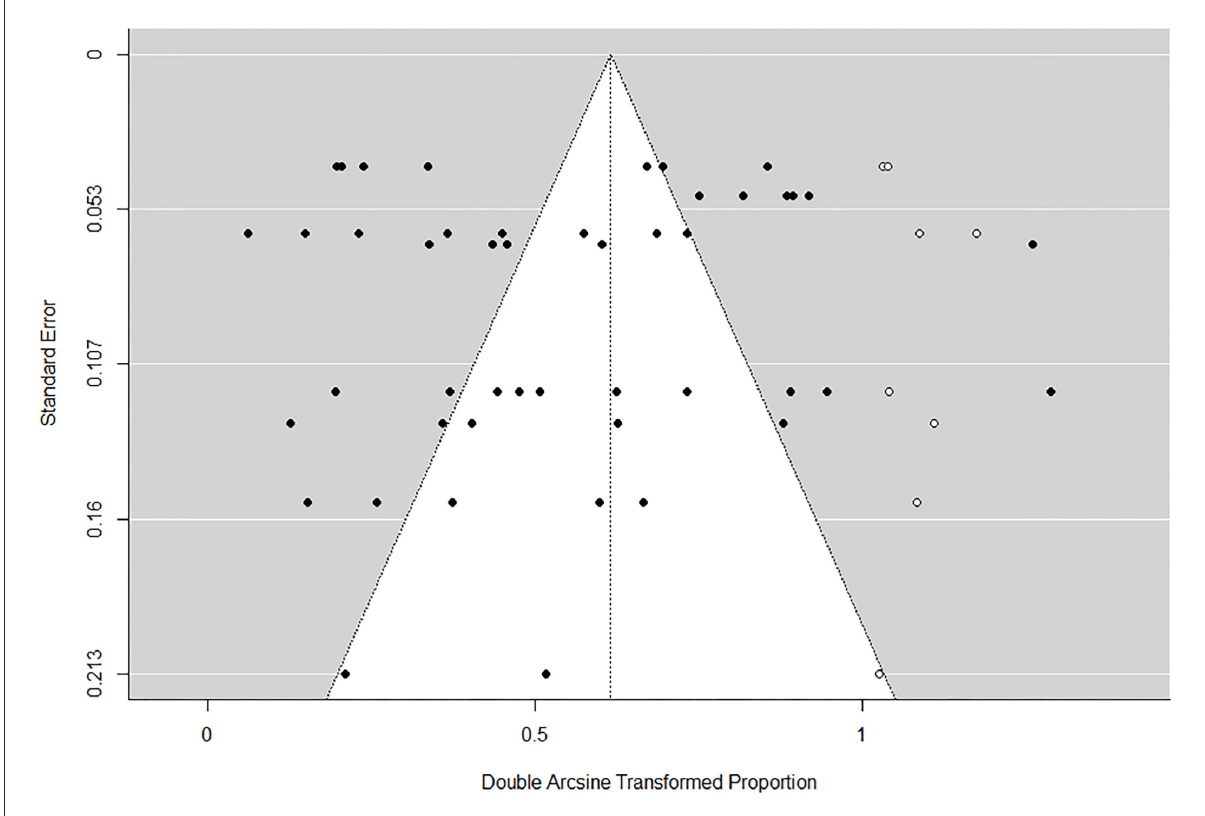
FIGURE8 Publication bias of antimicrobial resistant rate of Staphylococcus aureus